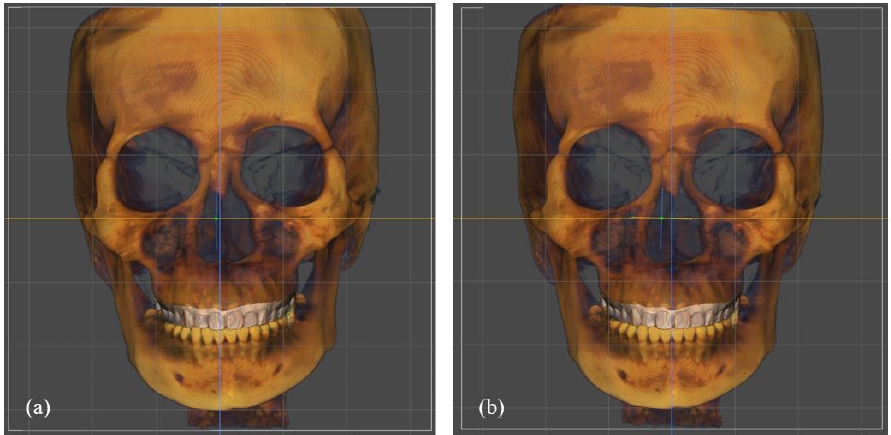
Figure 1. Reorientation process of the skull. ( a ) Before the reorientation, the coronal view reveals a canting of the skull. ( b ) After the reorientation.